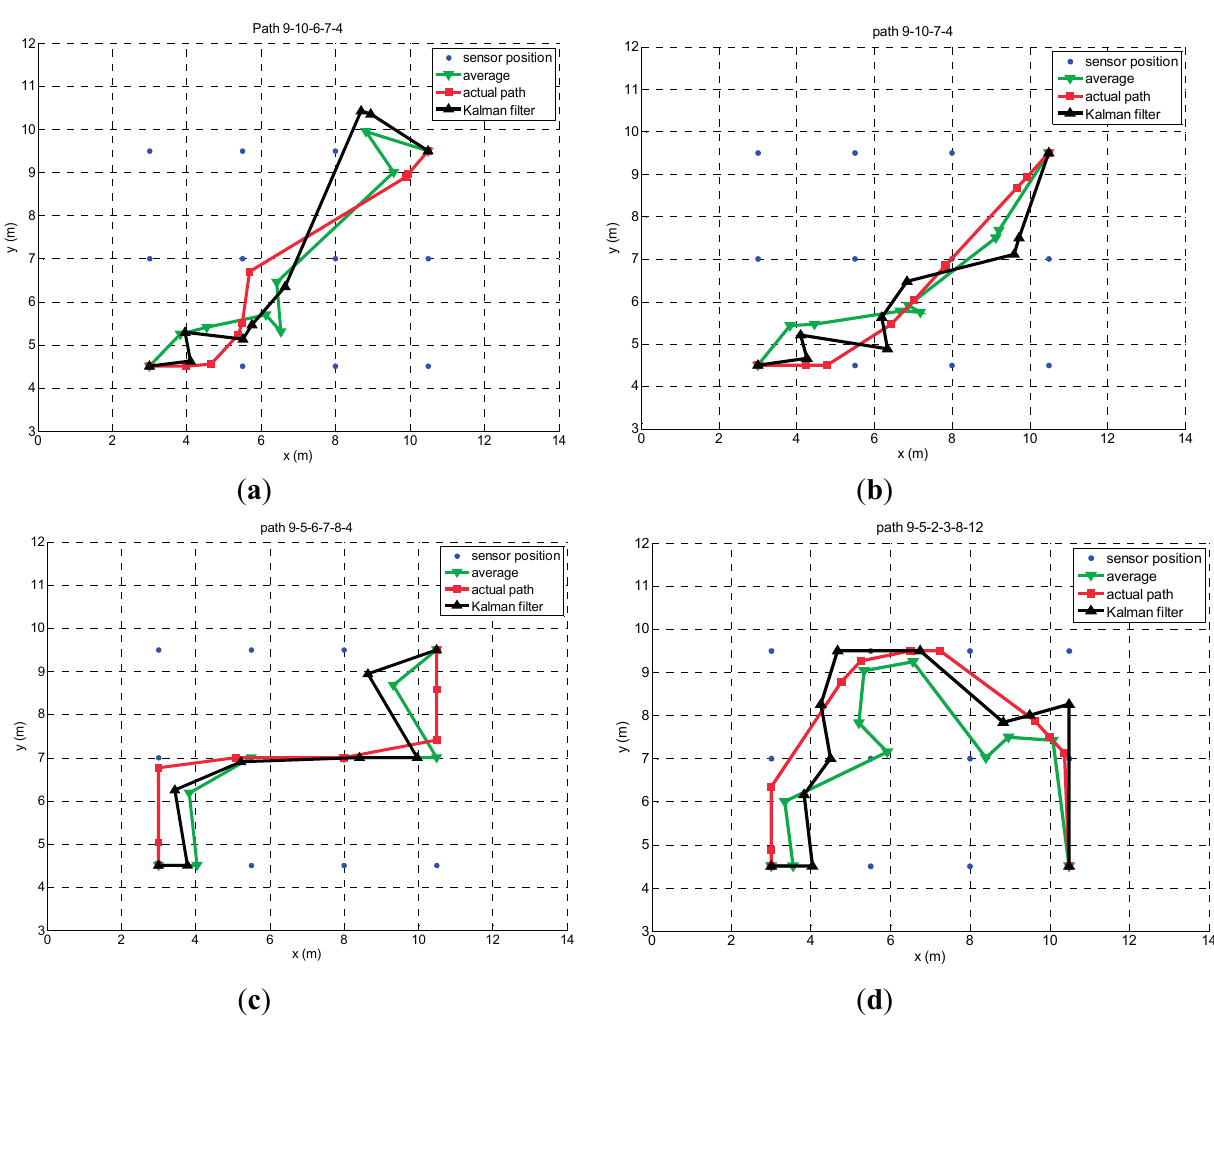
Figure 7. Estimated